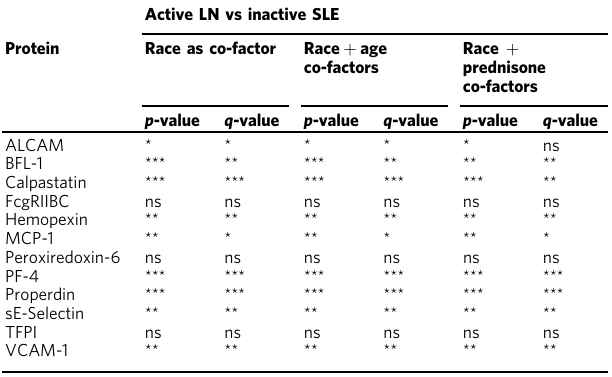
Table 4 Association of urine biomarkers with active LN status after adjusting for confounding factors. Active LN vs inactive SLE Protein Race as co-factor Race + age Race + co-factors